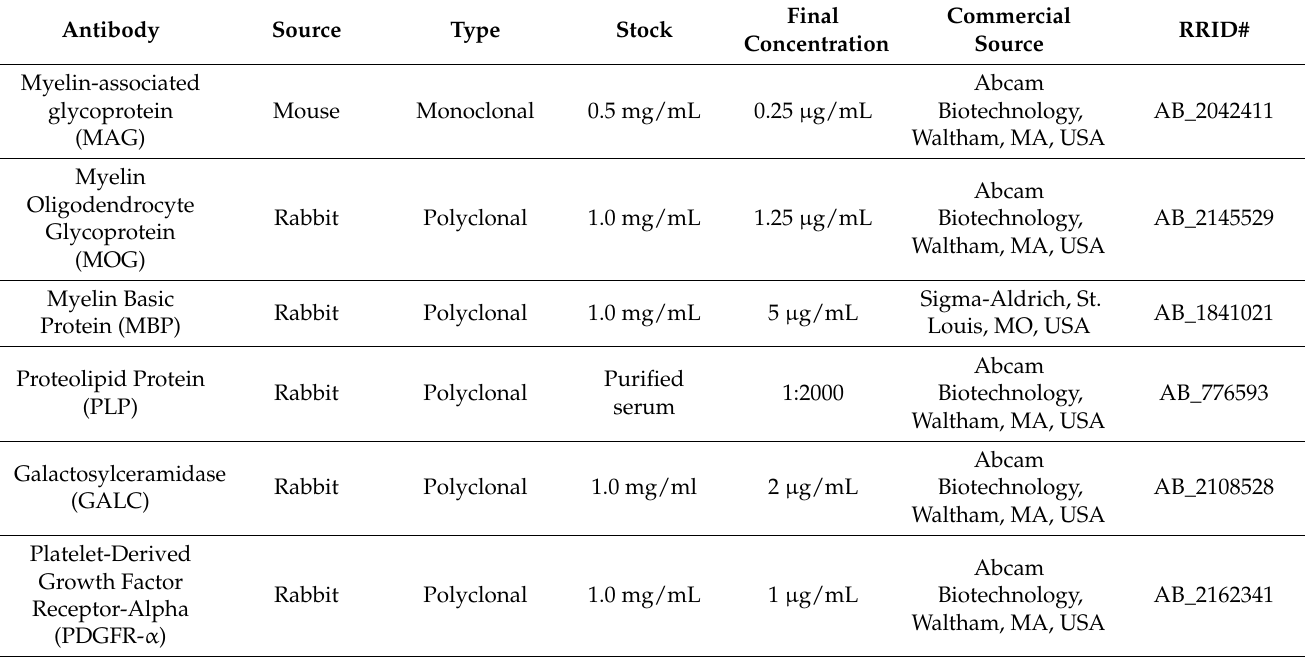
Table 5. Antibodies Used for Duplex ELISA